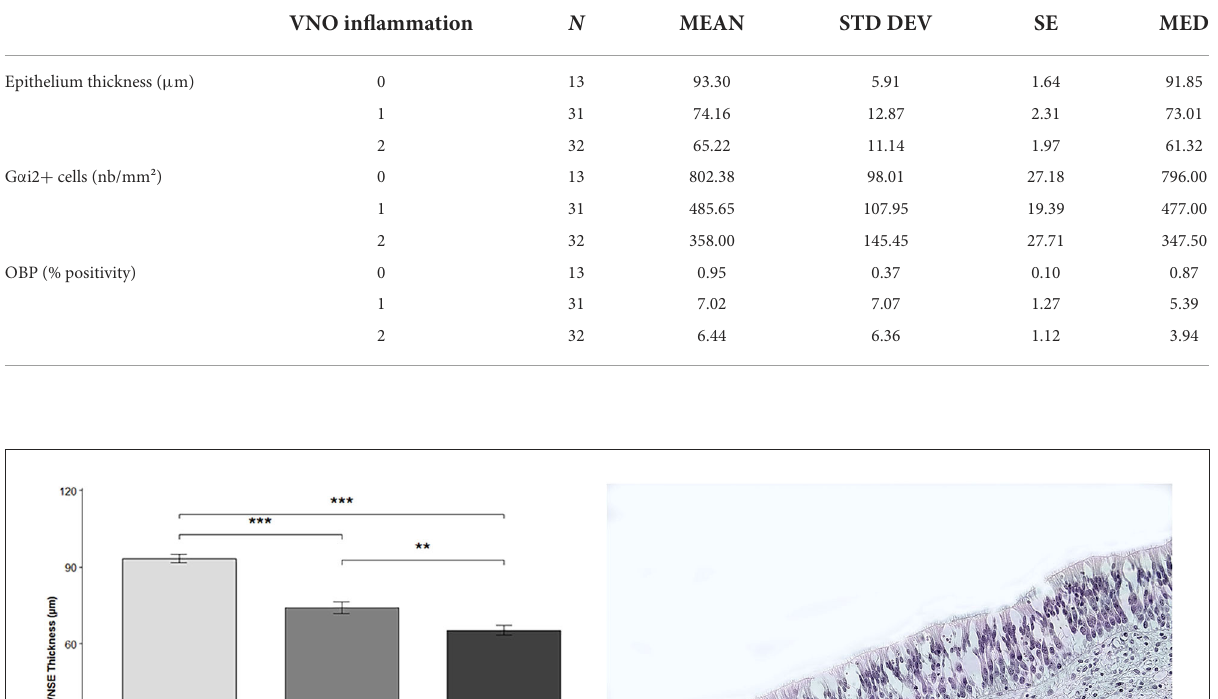
TABLE 1 Mean, standard deviation (STD DEV), standard error (SE), and median (MED) of epithelium thickness, G α i2 + cells, porcine odorant binding protein (OBP) according to the vomeronasal organ (VNO) inflammation score as 0 = absence; 1 = weak; 2 = moderate; 3 = strong inflammation.